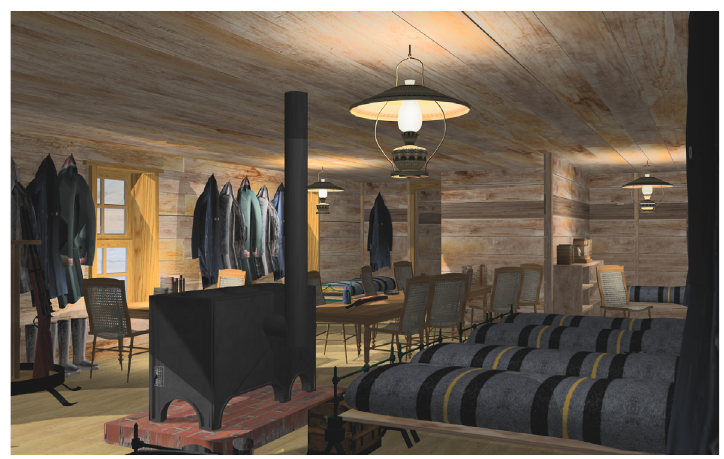
Figure 15. Computer reconstruction of the enlisted men’s quarters.